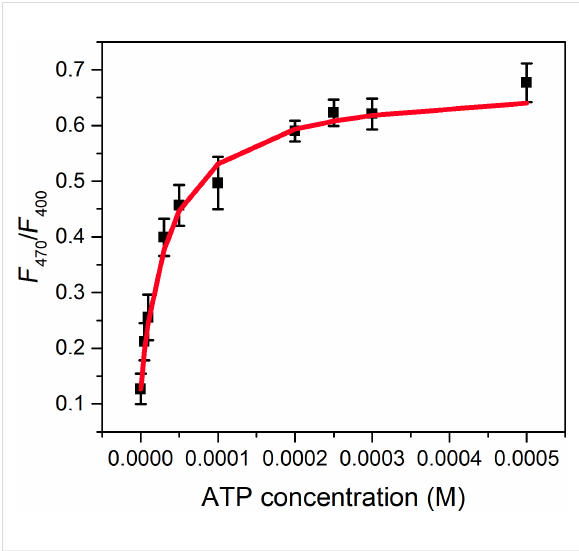
Figure 6: Ratio of the fluorescence intensities at 540 nm, the samples were excited at 470 and 400 nm. The red curve represents the result of a non-linear